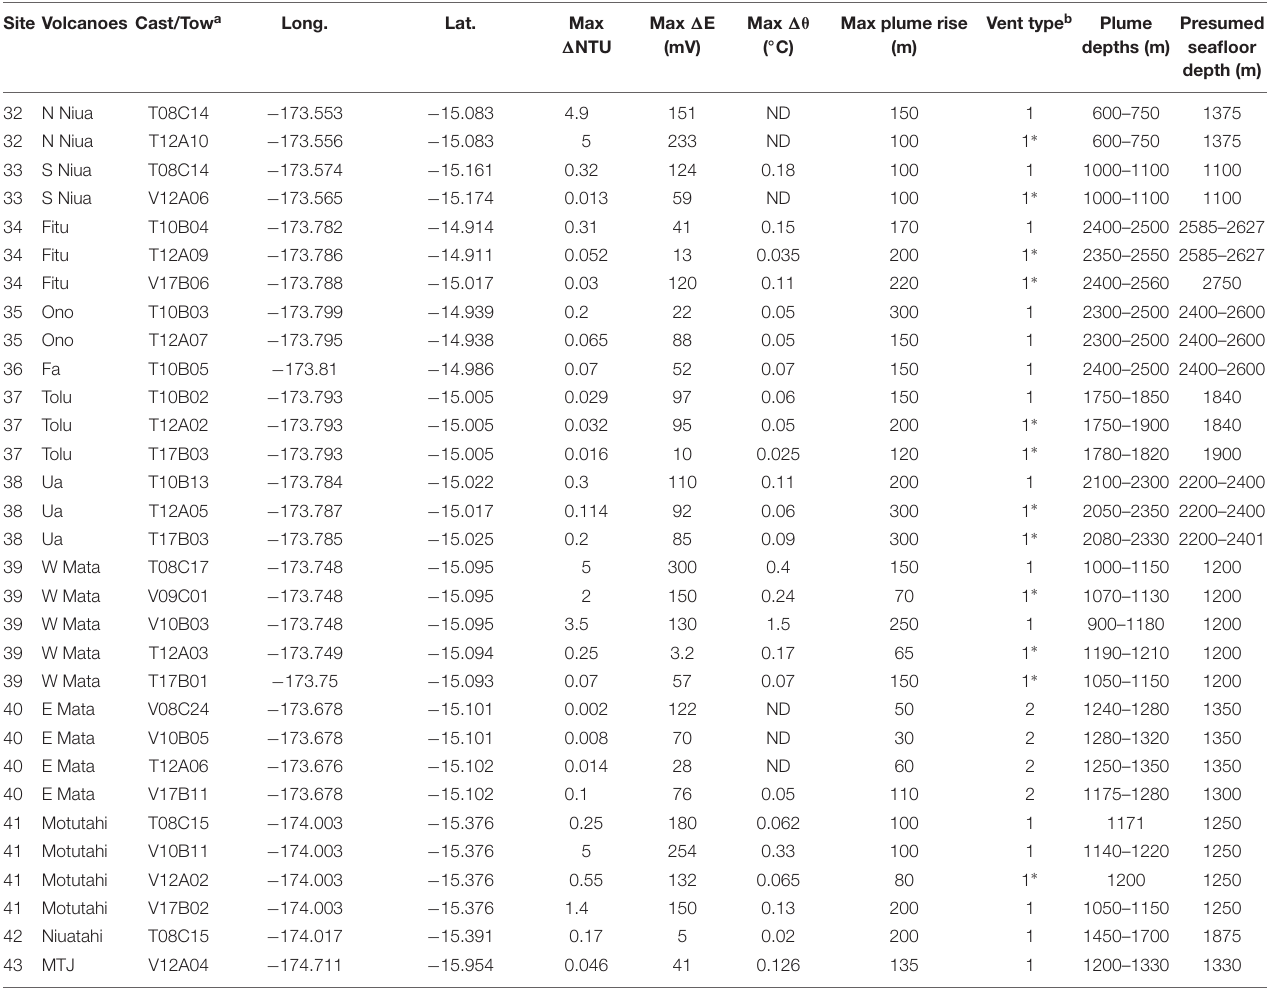
TABLE 2 | Characteristics of plumes from NE Lau Basin non-ridge volcanoes. Site Volcanoes Cast/Tow a Long.